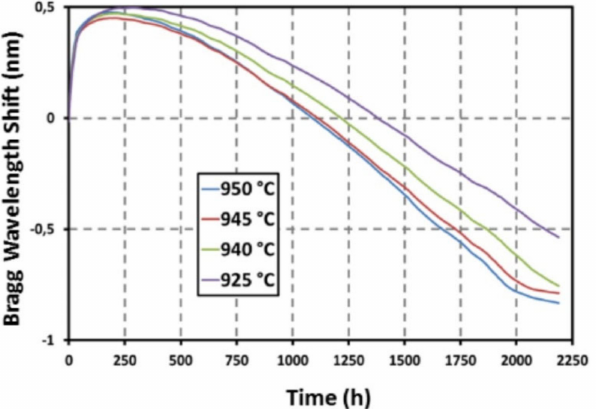
Figure 5. Bragg wavelength drift of 4 PbP FBGs annealed at high temperature (reproduced from